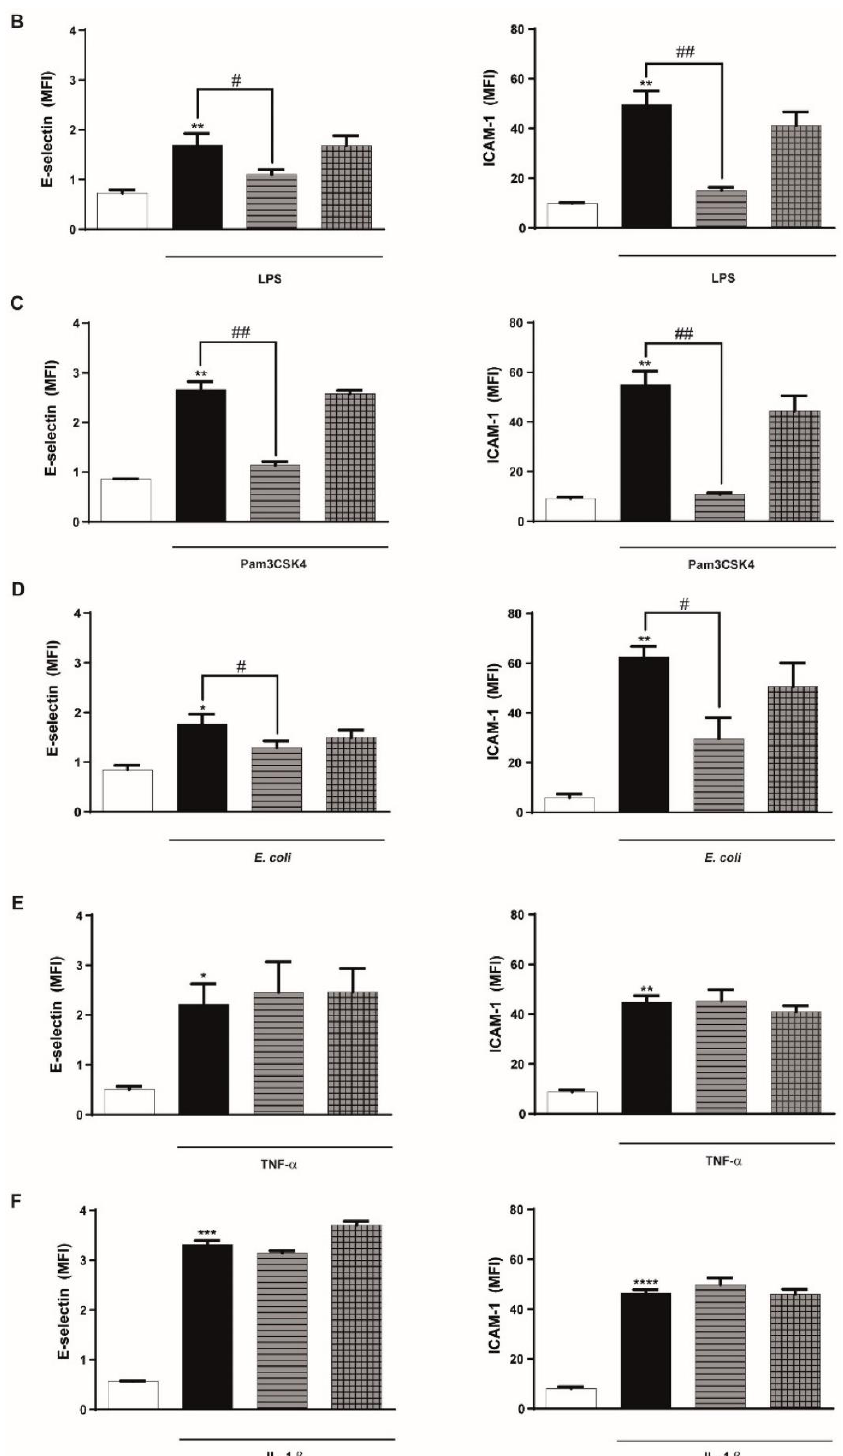
Figure 2. ARC selectively inhibit the expression of E-selectin and ICAM-1 on stimulated endothelial cells. HUVEC were treated or not with nanoarchaeosomes (ARC) or liposomes (LIP) ( A ). HUVEC were incubated with nanoarchaeosomes (ARC) or liposomes (LIP) at a concentration of 50 μg /mL and stimulated with ( B ) LPS (1 μg /mL); ( C ) Pam3CSK4 (1 μg /mL); ( D ) E. coli (MOI = 0.01); ( E ) TNF- α (0.3 μg /mL) or ( F ) IL-1 β (0.1 ng/mL) Expression of E-selectin and ICAM-1 was evaluated 4 and 18 h after-stimulation, respectively (one-way ANOVA followed by Bonferroni multiple comparisons test); * p < 0.05, ** p < 0.01, *** p < 0.001 and **** p < 0.0001 vs. basal; # p < 0.05 and ## p < 0.01 between labeled groups. Results are the mean ± SEM of four to five independent experiments.